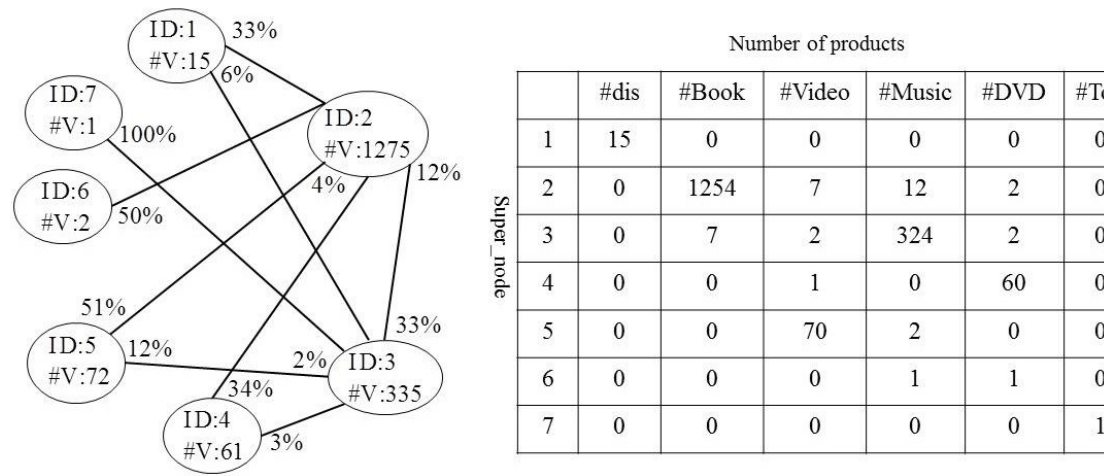
Figure 8: The fourth summary graph of the size of